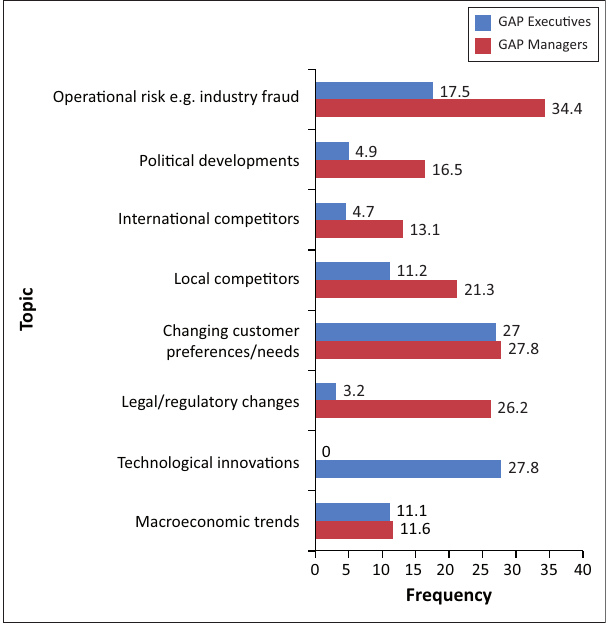
FIGURE 2: Gap between what intelligence decision makers required and what they were actually